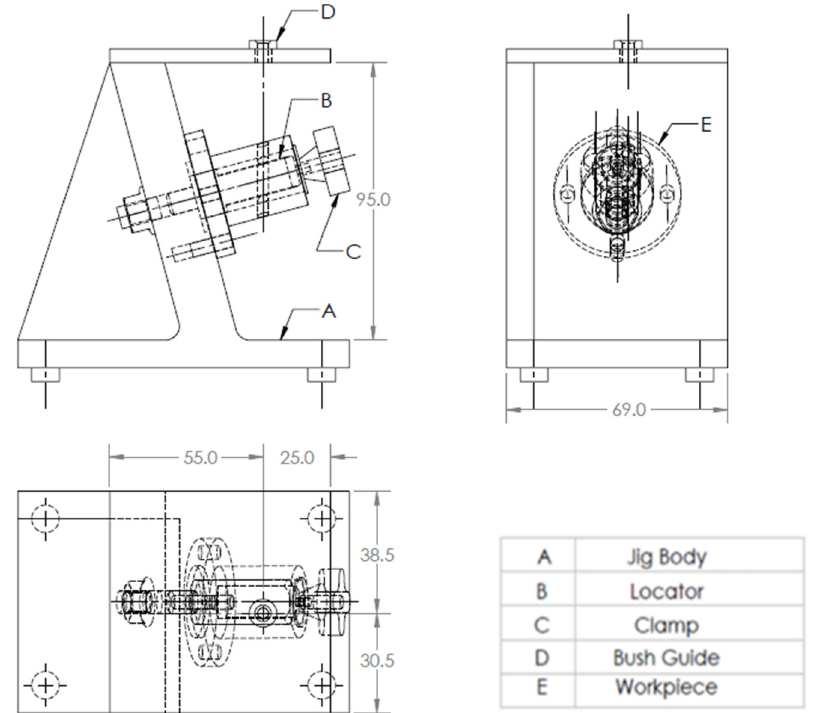
Figure 55. A drawing for the required jig design of the part.